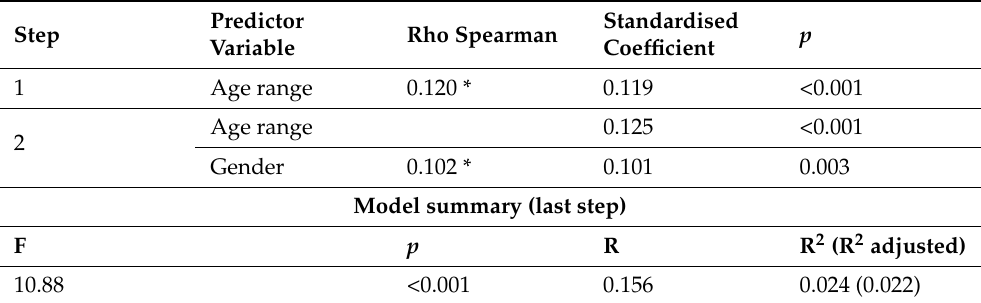
Table 7. Predictor variables for type of content. Source: own